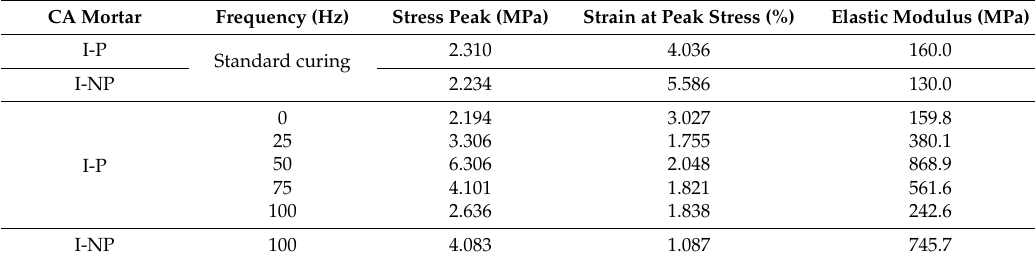
Figure 6. Effect of polymer emulsion incorporation on the stress-strain curve of the CA mortar after fatigue test (100 Hz). Table 5. Properties of the CA mortar after fatigue test under various vibrating frequencies.